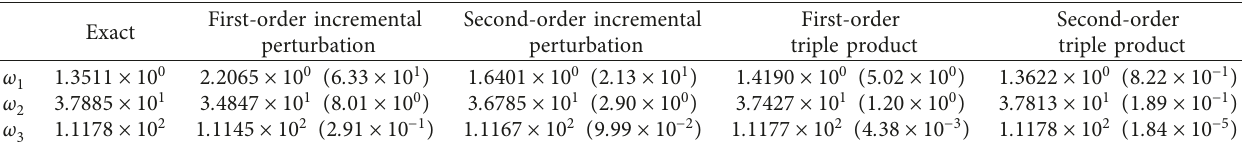
1 . 8. (cid:31) 8 for σ 1 . 8. (cid:31) (cid:31) Second-order triple product